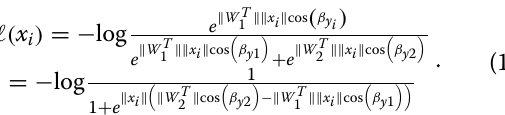
ℓ cls = ℓ PGL + ℓ soft max